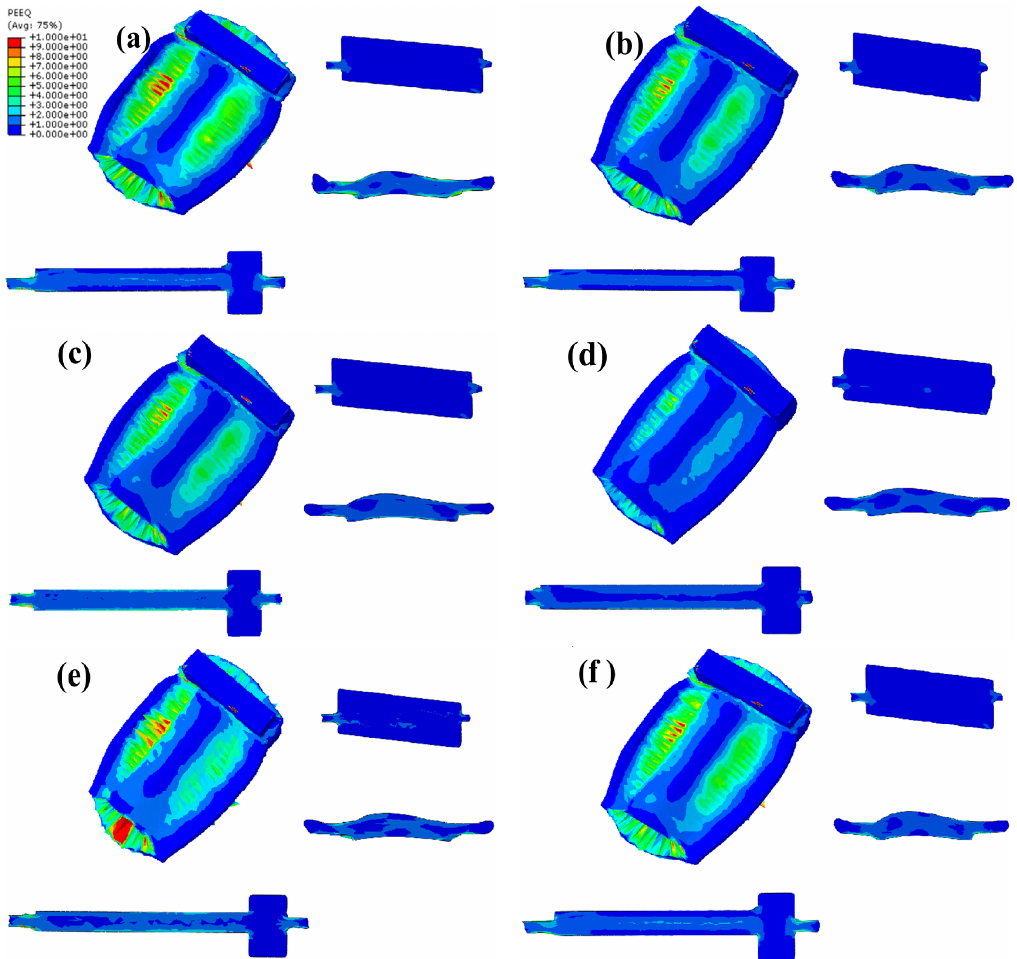
Figure 5. Effective strain distributions at different forging temperatures and strain rates: ( a ) 900 °C, 0.01 s − 1 ; ( b ) 930 °C, 0.01 s − 1 ; ( c ) 950 °C, 0.01 s − 1 ; ( d ) 1000 °C, 0.01 s − 1 ; ( e ) 950 °C, 0.05 s − 1 ; ( f ) 950 °C, 0.005 s − 1 .